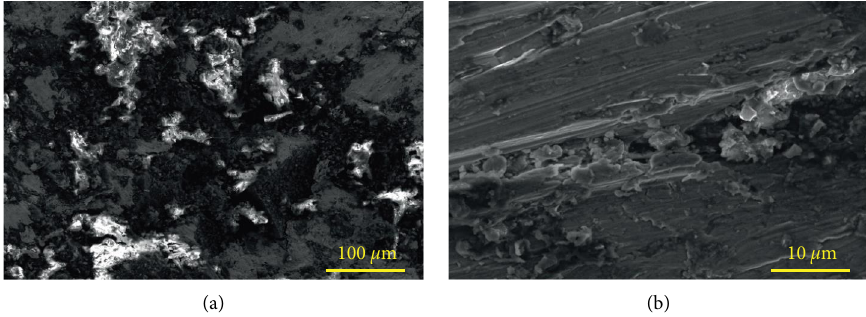
Figure 8: Case Al-Si/63% SiCtest specimen (a) Initiation of Fatigue crack (b) Deformation in particle-matrix